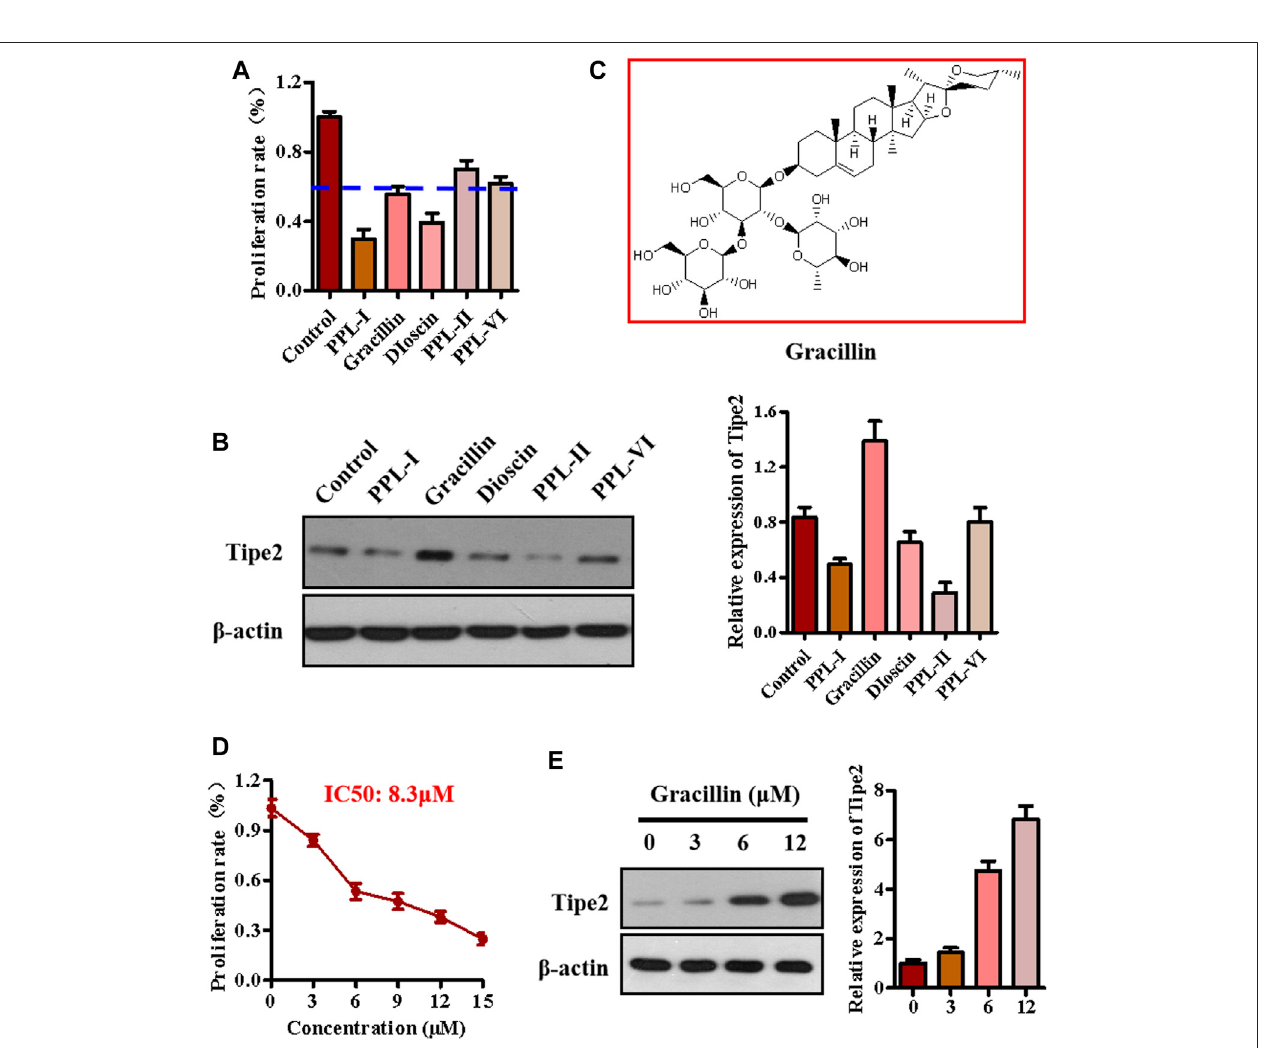
FIGURE 2 | The effect of gracillin on TIPE2 expression and cell proliferation in BGC-823 cells. (A) The effect of fi ve active compounds on cell proliferation. 5 μ M active compounds were used to treat the BGC823 cells for 48 h. (B) The effect of fi ve active compounds on TIPE2 expression. 5 μ M active compounds were used to treat the BGC823 cells for 12 h. (C) The structure of gracillin. (D) The effect of gracillin at different concentrations on cell proliferation. The different concentrations of gracillin with 3, 6, 9, 12, 15 μ M were used to treat the BGC823 cells for 12 h. (E) The effect of gracillin with the indicated concentrations for 12 h on TIPE2 expression. The values of the histogram are displayed as mean ±